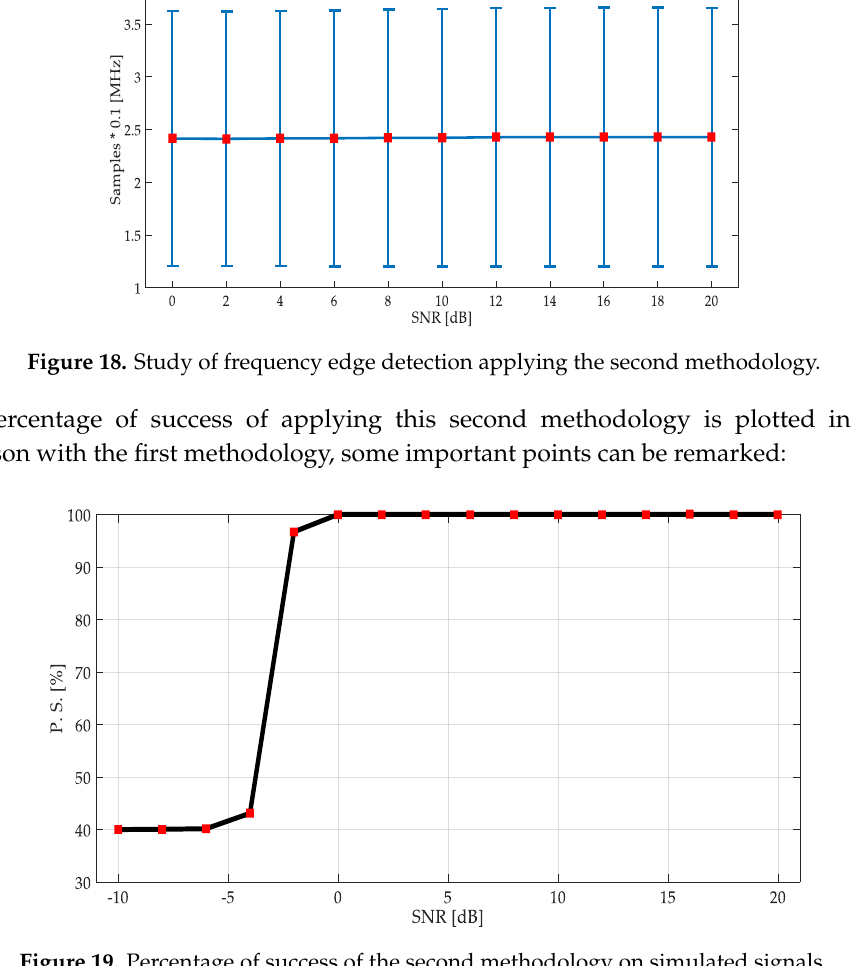
Figure 17. Mean and standard deviation for noise and simulated symbols (OFDM and NRZ-CDMA) applying the second methodology.